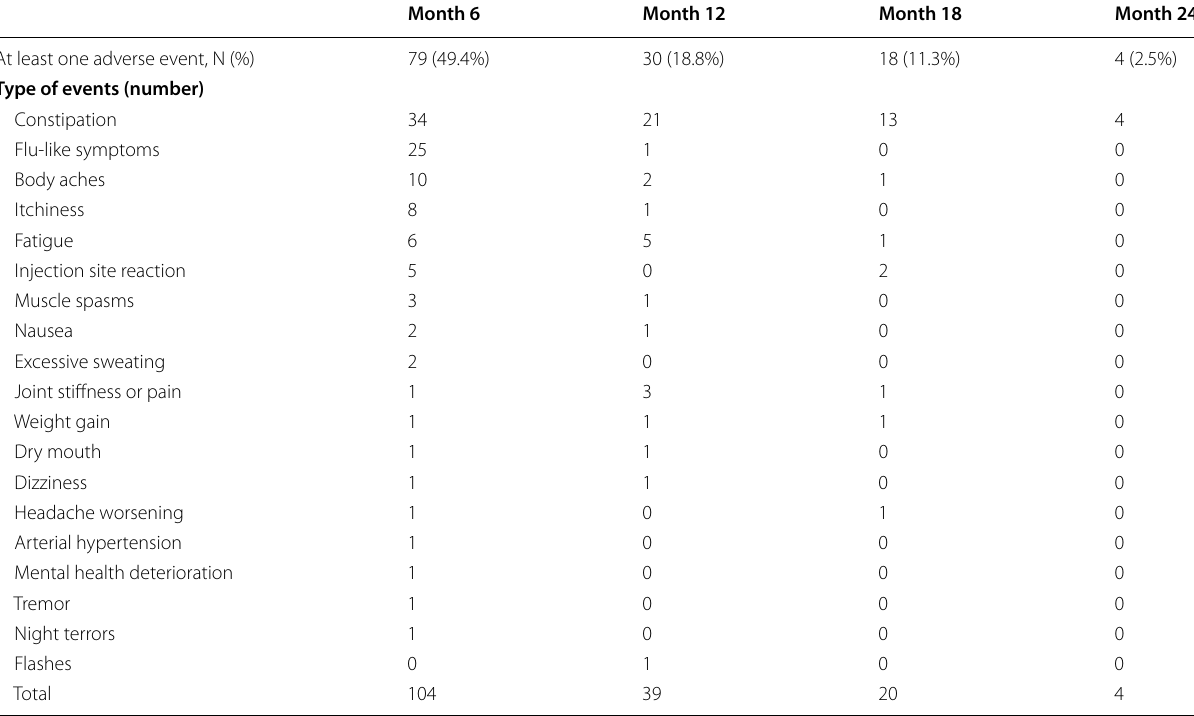
Table 3 Percentage and types of adverse events in patients treated with erenumab at month 6, 12, 18 and 24